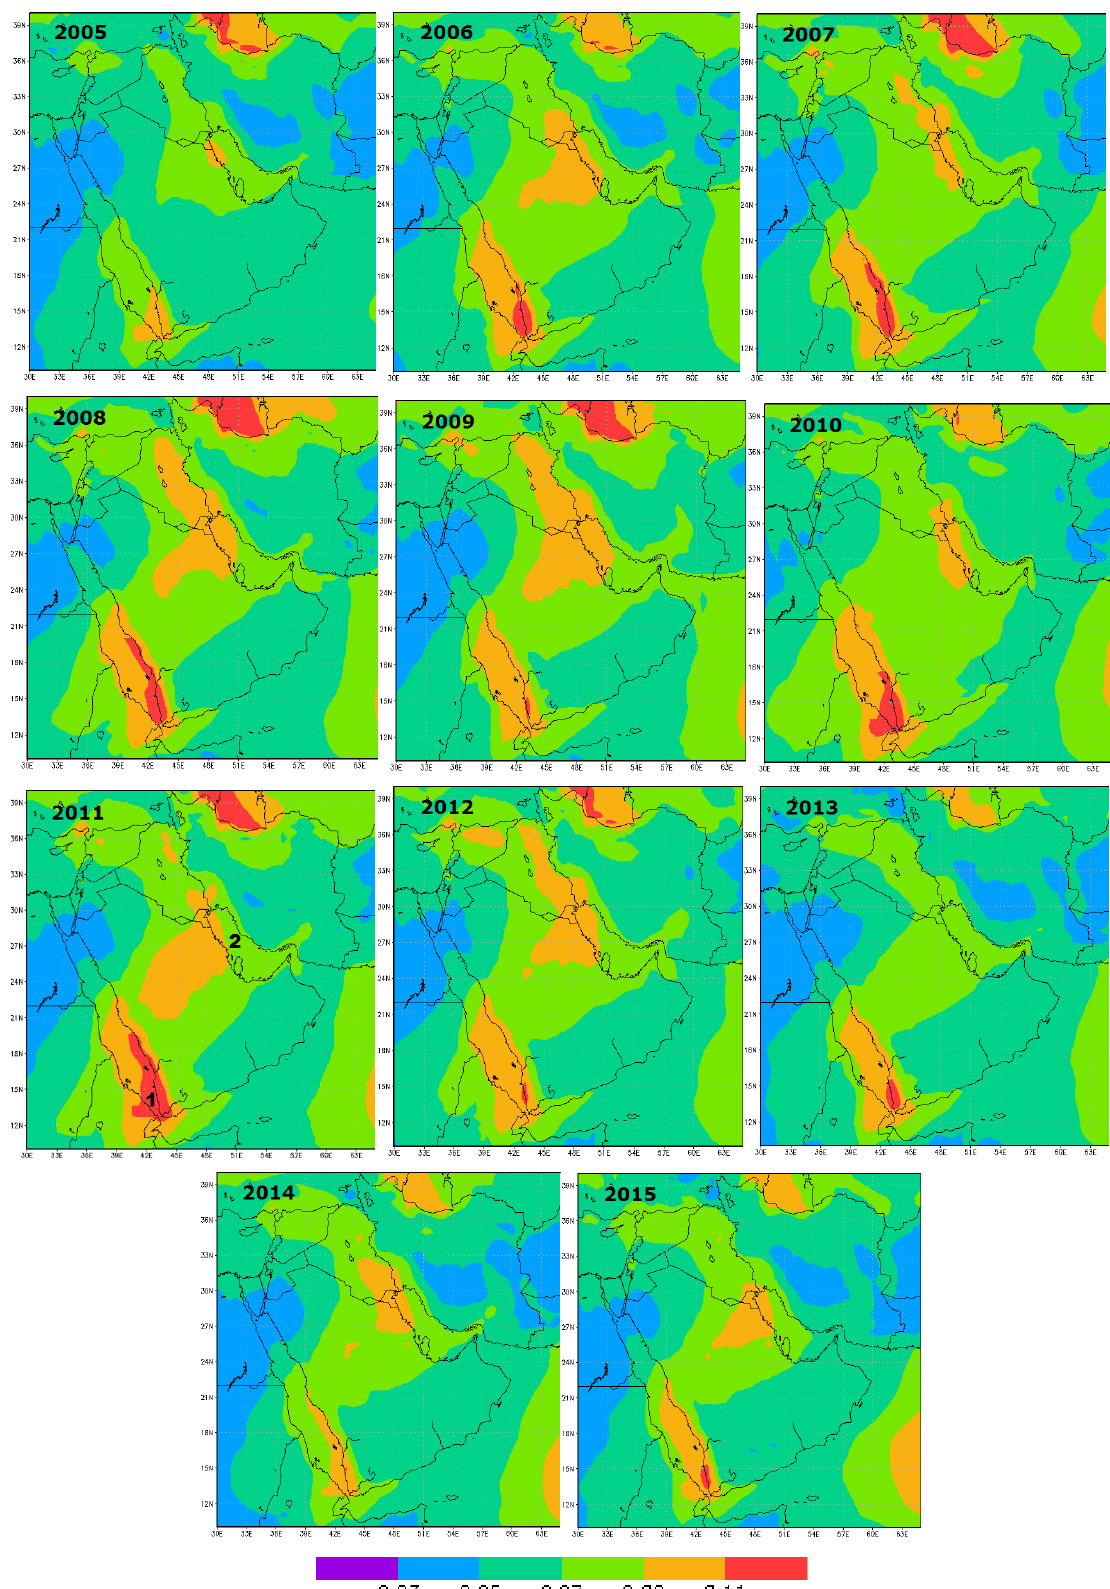
Figure 3. Inter-annual variation of Sulfate AOT over the Arabian Peninsula from 2005 through 2015. Also shown in the 2011 figure panel: (1) The region of shipping and volcanic activity in south western Arabian Peninsula (Yemen and Saudi Arabia), including the industrial region of Jeddah and population centers of Sanaa; (2) the industrial region in the Arabian gulf region that includes Dammam, Kuwait, Bahrain, and Qatar.